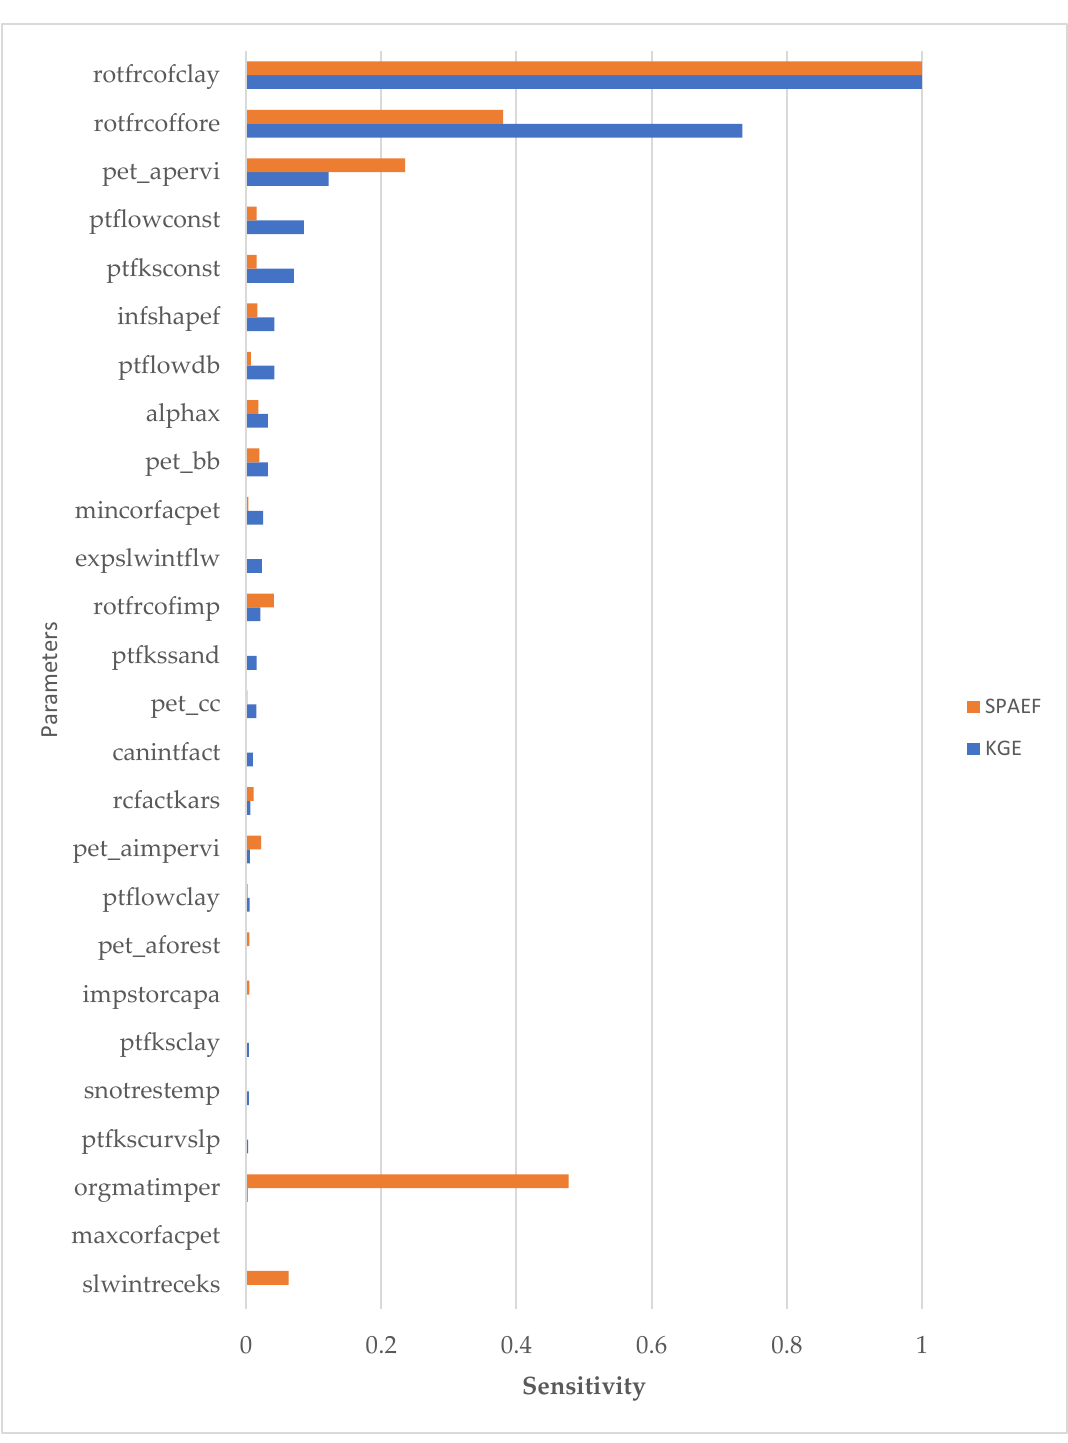
Figure 4. The most sensitive twenty-six parameters according to the objective function of SPAEF and KGE.